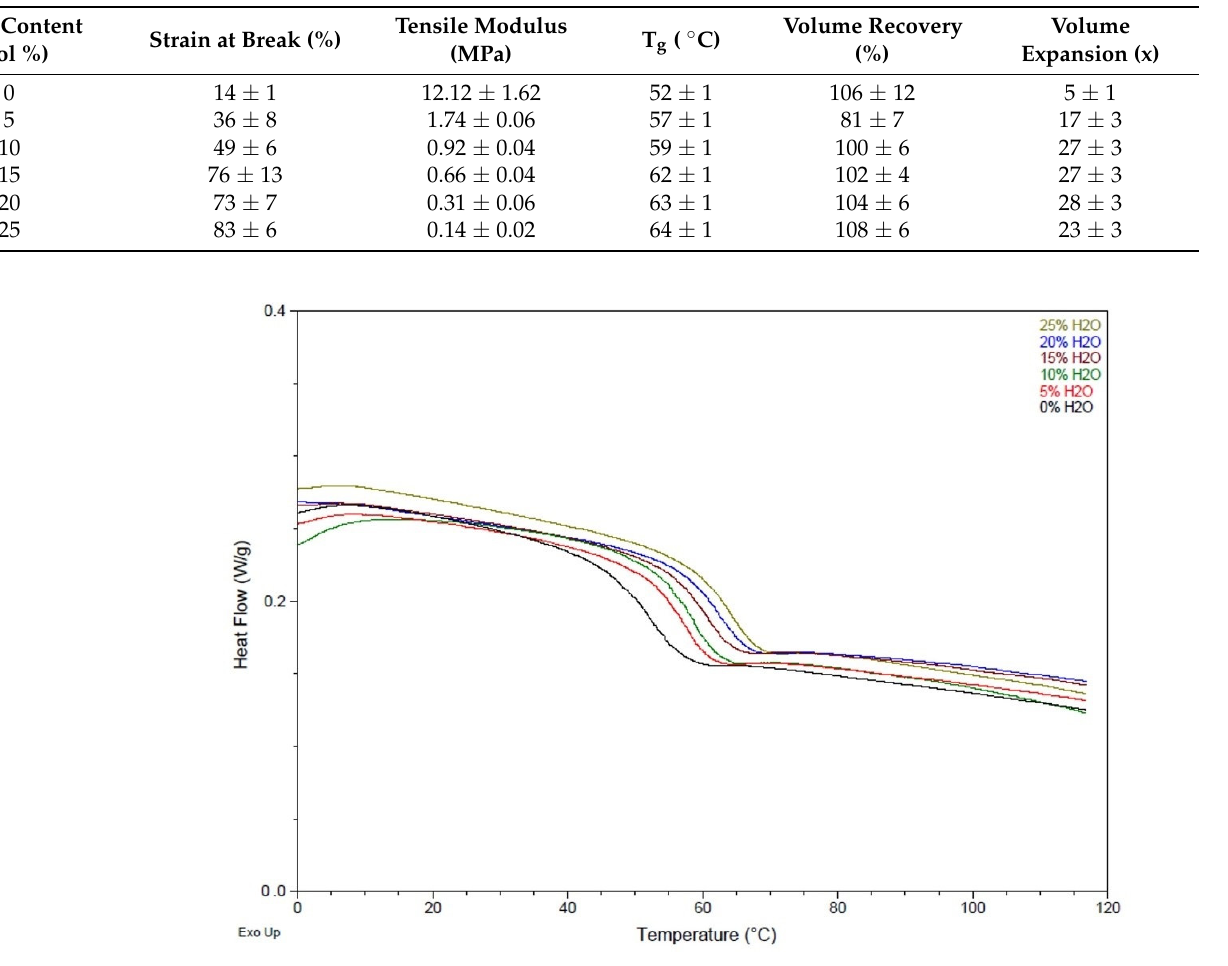
Figure 4. TGA thermogram of SMP foams with varying water